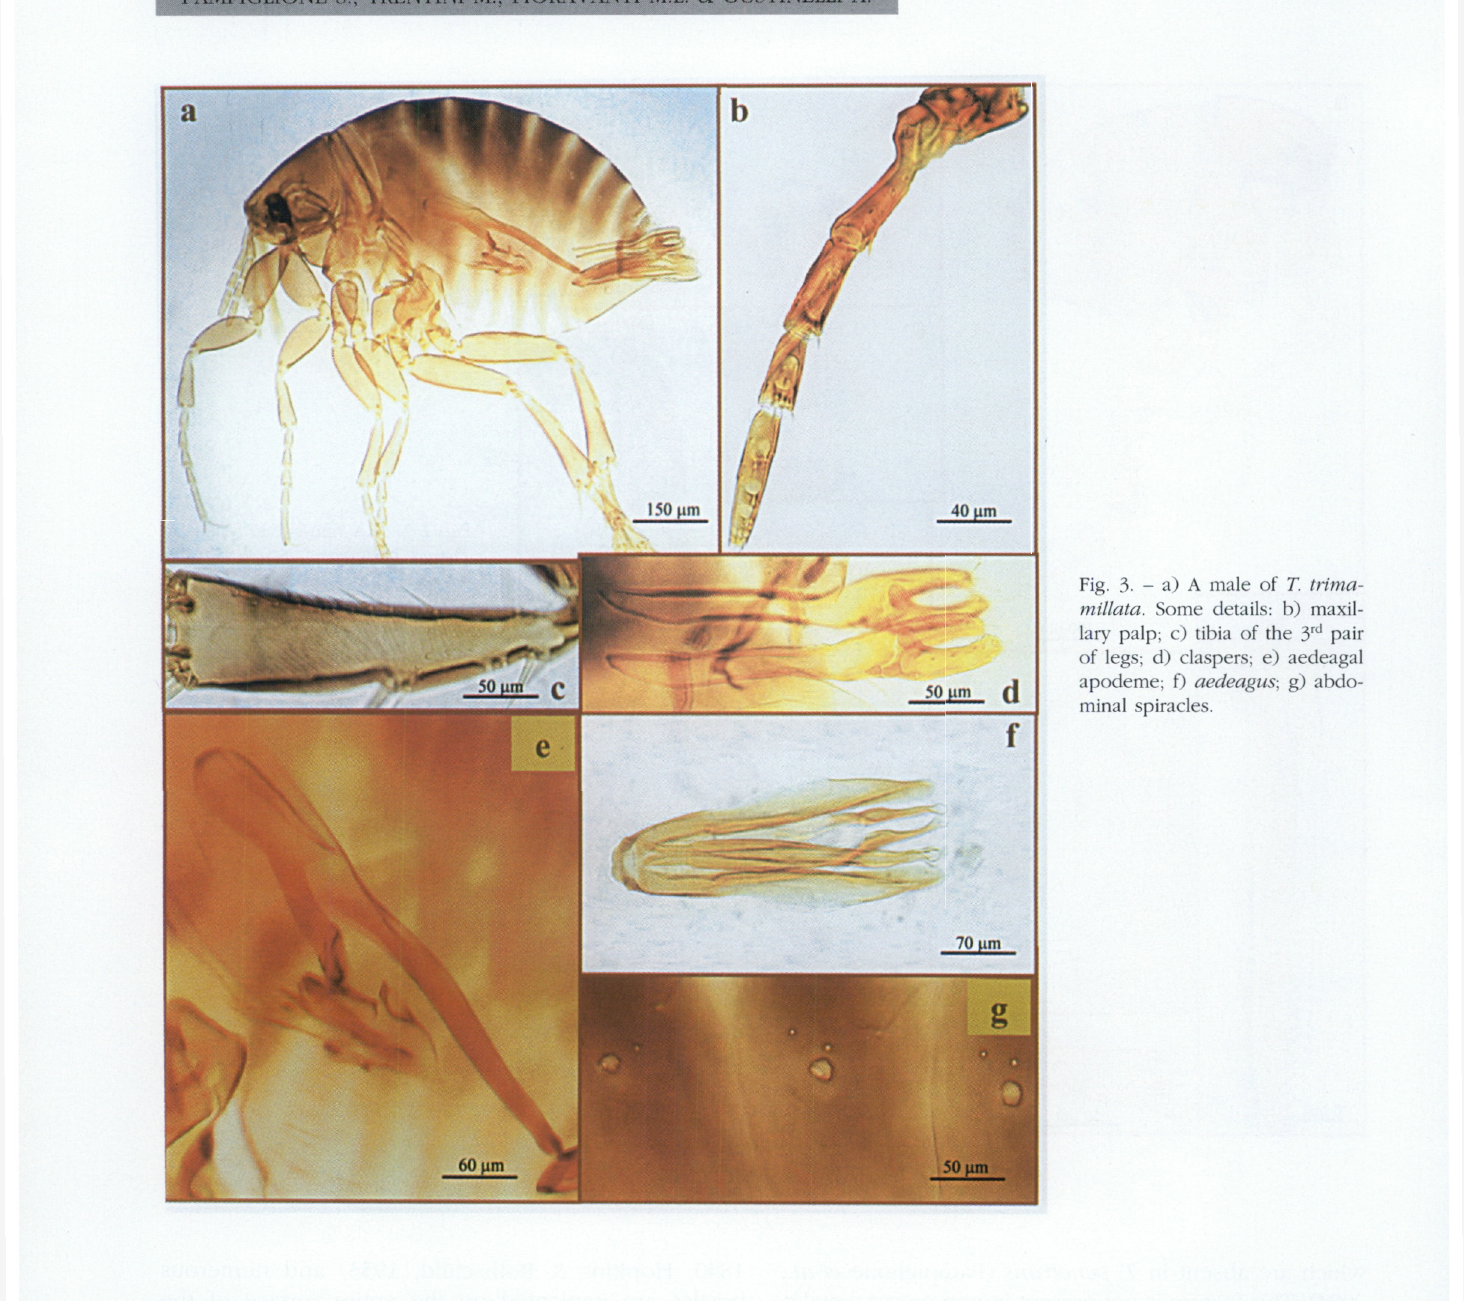
Fig. 3. - a) A male of T. trima­ millata. Some details: b) maxil­ lary palp; c) tibia of the 3rd pair of legs; d) claspers; e) aedeagal apodeme; f) aedeagus ; g) abdo­ minal